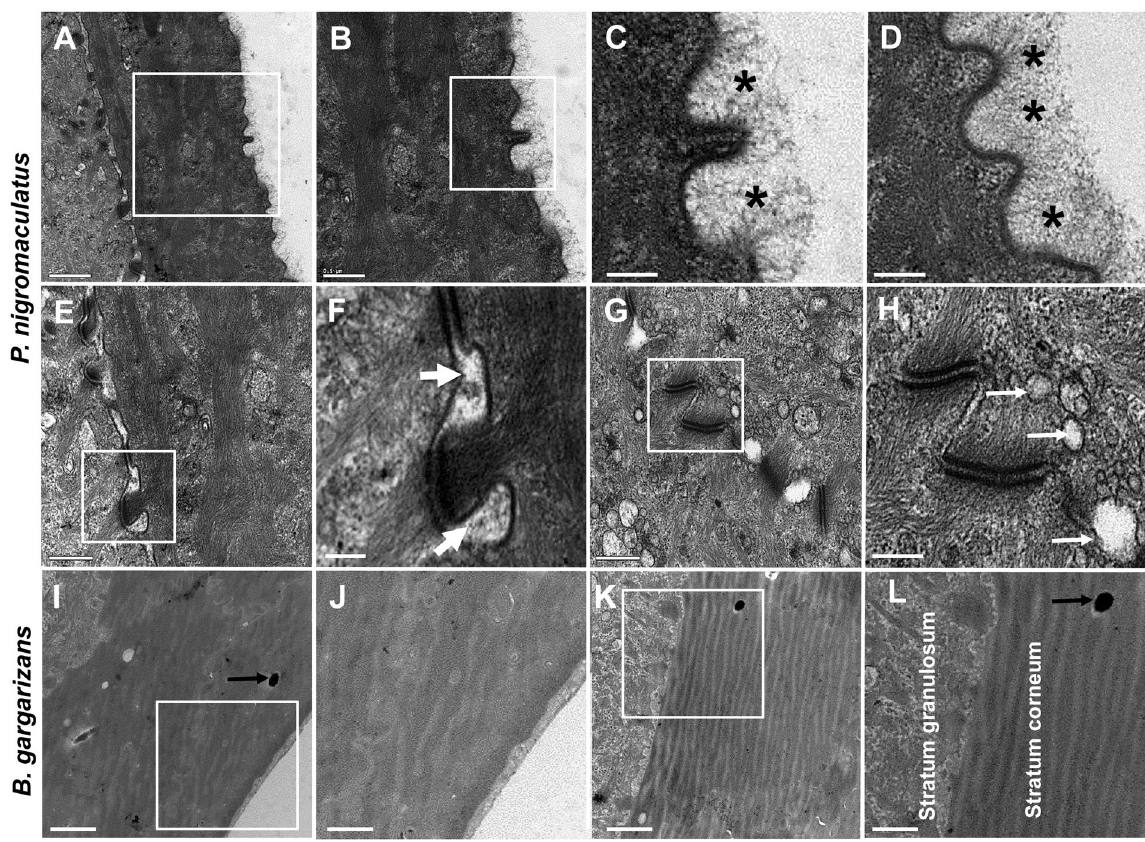
Figure 9. Ultrastructure of the dorsal stratum corneum in P. nigromaculatus and B. gargarizans by TEM. TEM observations of the dorsal stratum corneum in P. nigromaculatus and B. gargarizans . Nicks ( A–C ) and mucus layer ( B–D , asterisk) in the surface of the dorsal skin in P. nigromaculatus . Degrading desmosome ( E,F ) with large separation bands and typical desmosomes ( G,H ) with bubbles ( H ). Smooth surface of thoroughly keratinized stratum corneum ( I,J ) and lack of cellular junctions ( K,L ) in the stratum corneum in B. gargarizans . The white thick arrow shows separation bands, and the white thin arrow shows a bubble. The small black arrow shows a pigment granule. B, C, F, H, J, and L show enlarged images of the boxes in A, B, E, G, I, and K, respectively. Scale bar, A, I, K: 1 μ m; B, E, G,: 0.5 μ m; C-D, F, H: 0.2 μ m; J, L: 0.3 μ